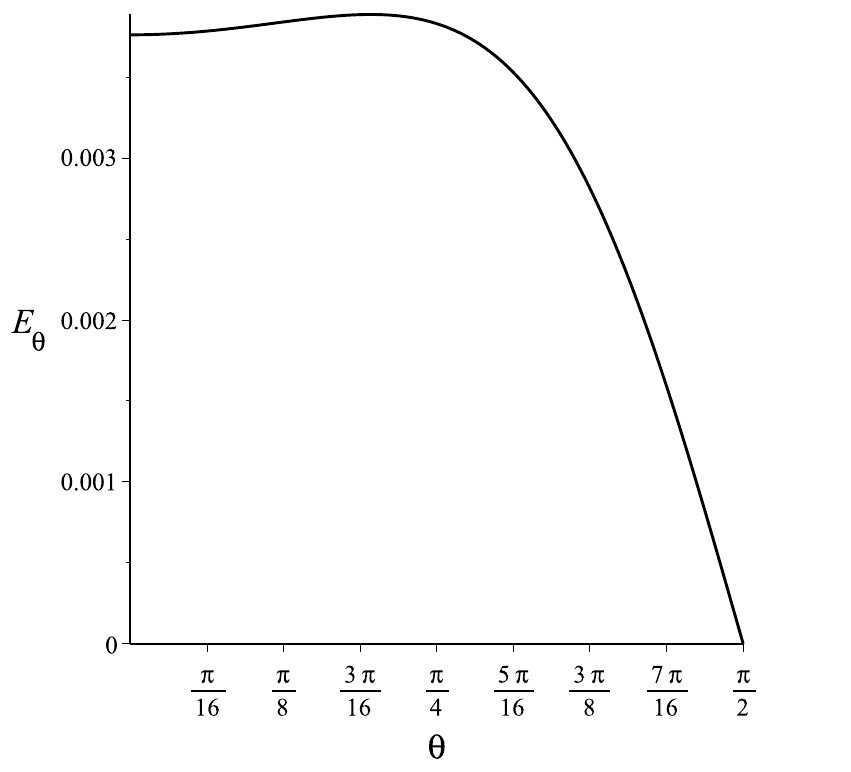
Figure 4 . The electric field on the event horizon, as a function of θ , for an extremal AdS 4 -Kerr- Newman magnetic black hole with L = 100 , a = 50 , P = 501 . 3 . (Units are Planck